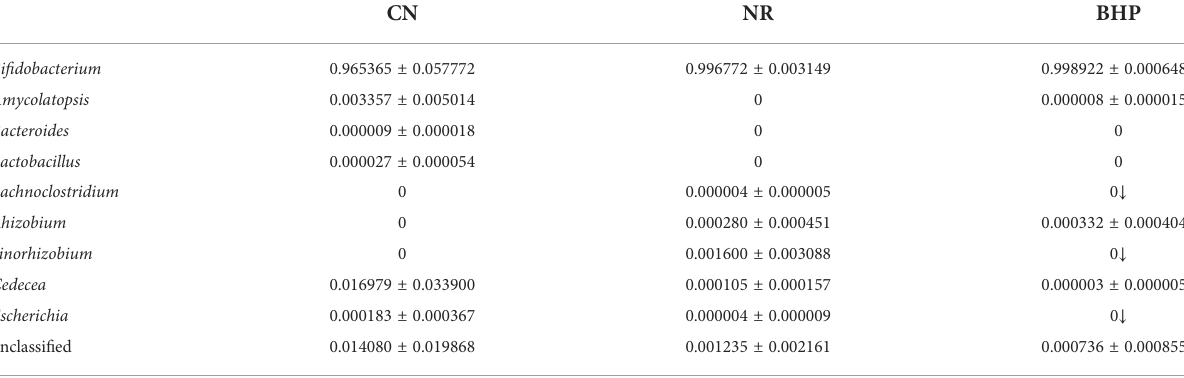
TABLE 2 Relative abundance of lactase-producing bacteria in each group at the genus